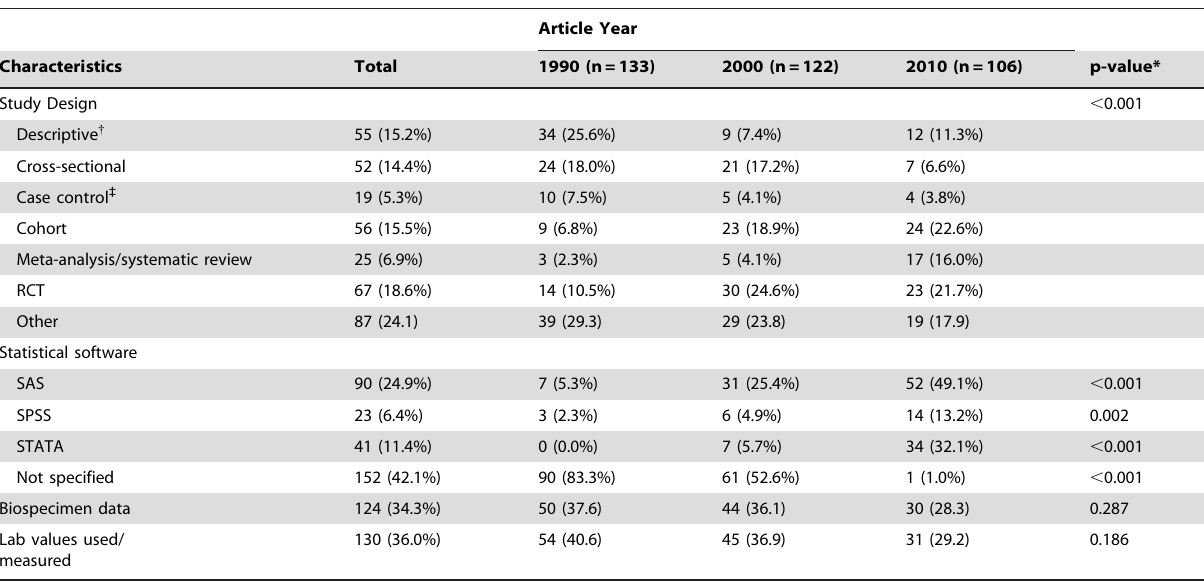
Table 1. Characteristics of 361 articles published in JAMA , 1990, 2000, 2010.